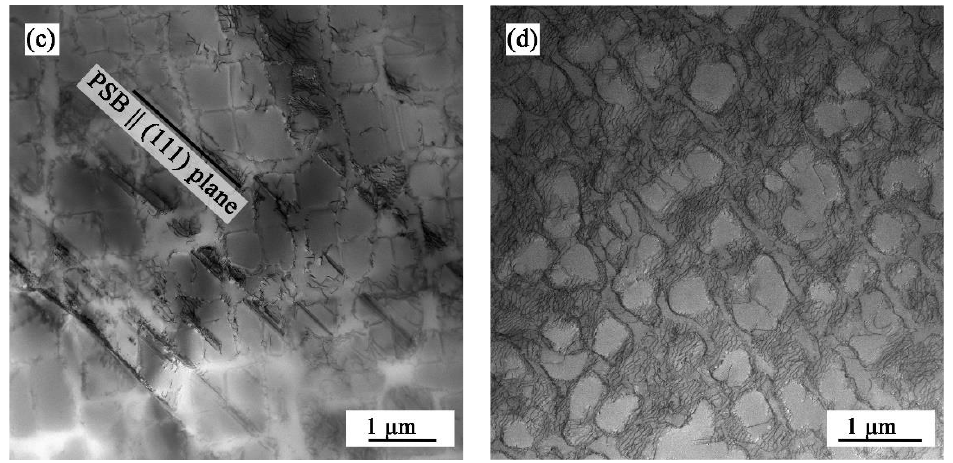
Figure 11. TEM images of dislocation arrangement after TMF tests under OP loading ( a , b ) 300 – 900 °C, ( c , d ) 500 – 900 °C.